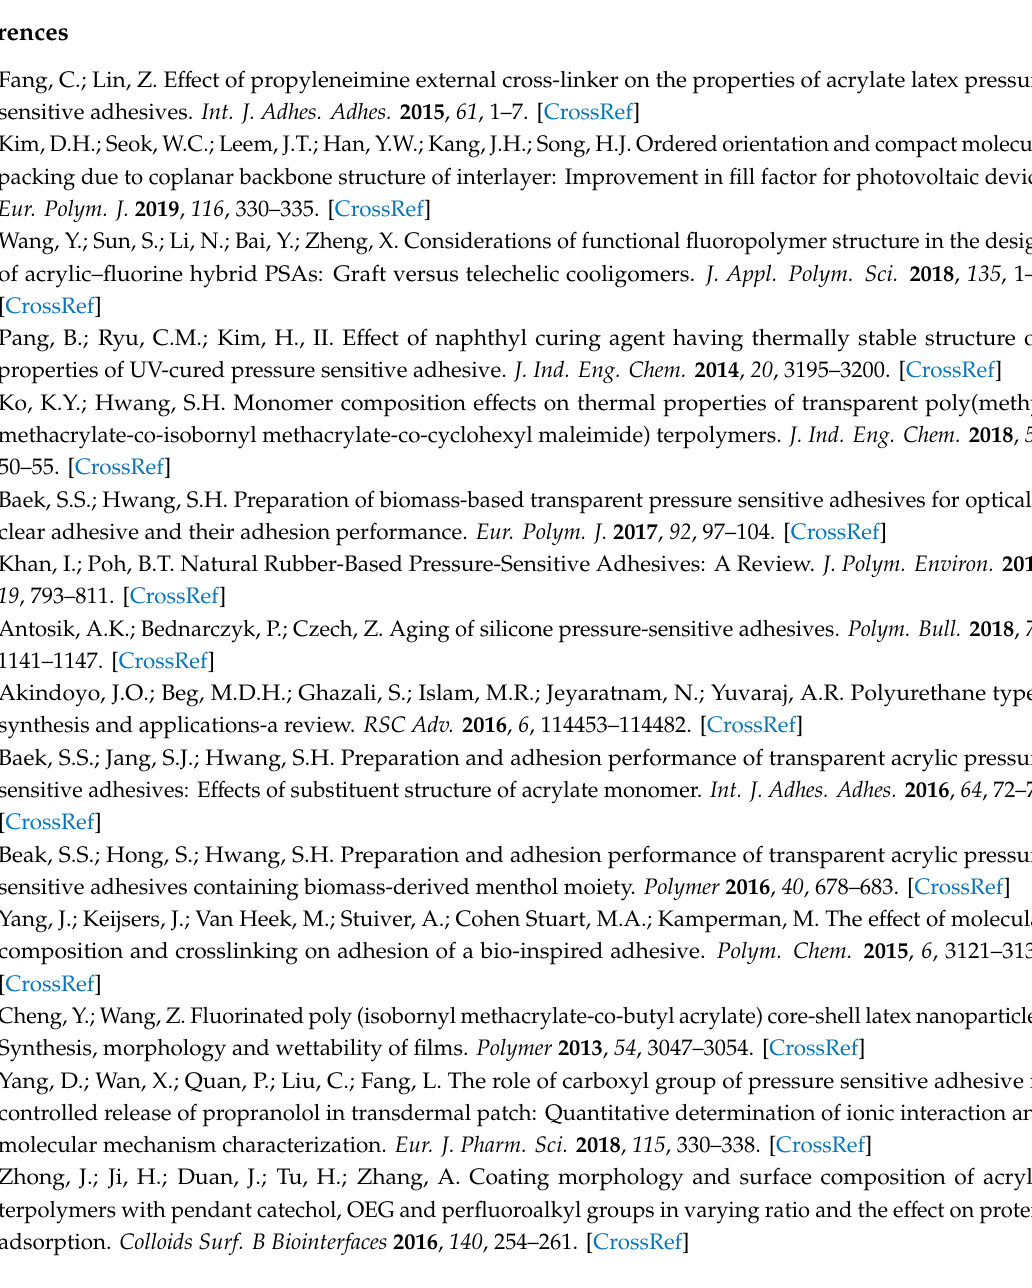
Figure S1: FT-IR spectrum of acrylic PSA films for HEA content: total region, Figure S2: 1 H-NMR spectrum of acrylic pre-polymers for HEA